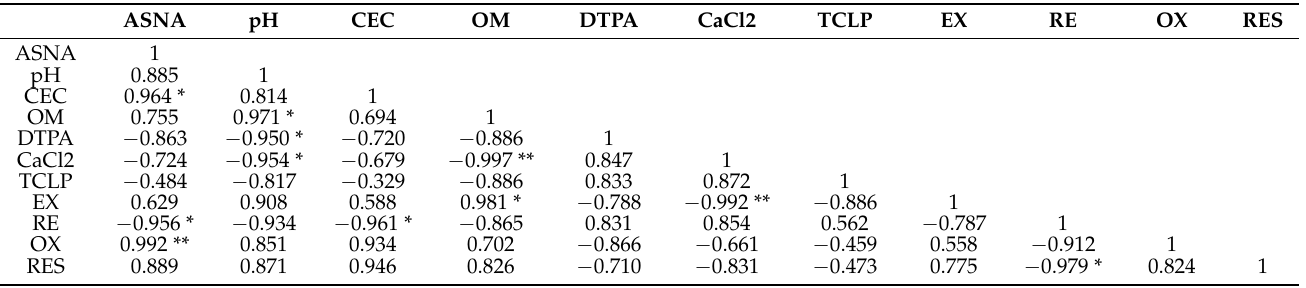
Table 2. Correlation analysis of Pb chemical speciation, bioavailability, ASNA addition, and soil physicochemical